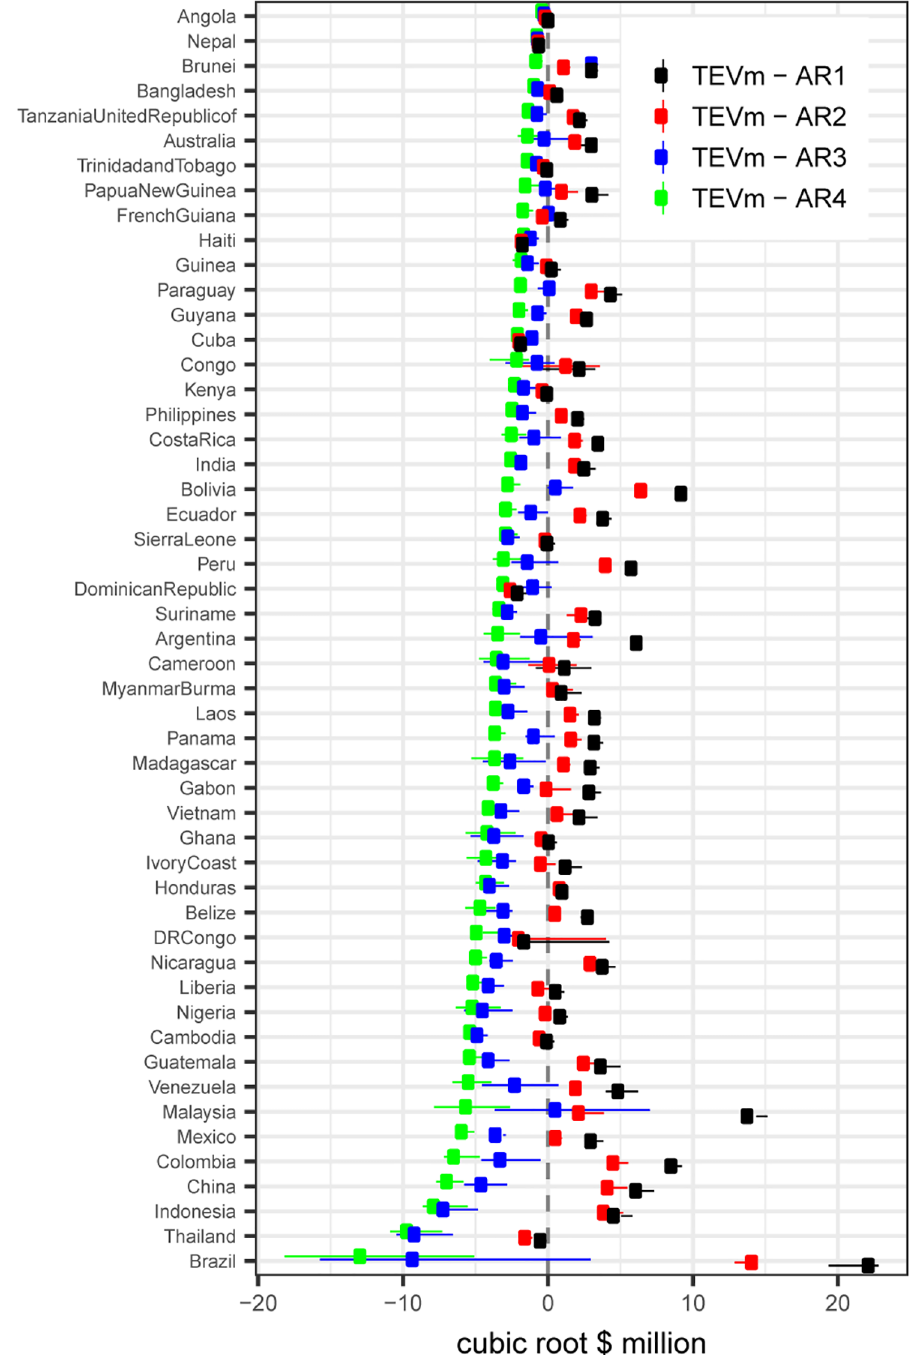
Fig 3. Annual per-country net benefits of converting tropical forests to agriculture for the years 2000– 2012 compared to total ecosystemservicesvalue (TEV) losses. This figure shows the result of deducting cubic root–transformed agriculturalrents (ARs) of the crops replacingforests under 4 different scenarios(A, B, C, and D with corresponding agriculturalrents AR1, AR2, AR3, and AR4) to the cubic root TEV basedon the market price of carbon (TEVm)—i.e., TEV 1/3 –AR 1/3 . Error bars indicatethe 2.5th and 97.5th percentilesof the uncertainty distribution of